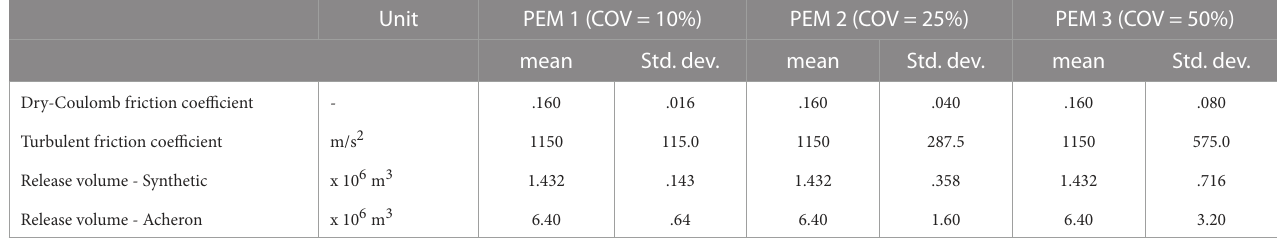
TABLE1 MeanandstandarddeviationvaluesoftheinputvariablesusedinthePointEstimateMethod(PEM)analysisofthesyntheticcaseandAcheronrock avalanche.SamevaluesofDry-Coulombandturbulentfrictioncoefficientsareusedforbothcases.